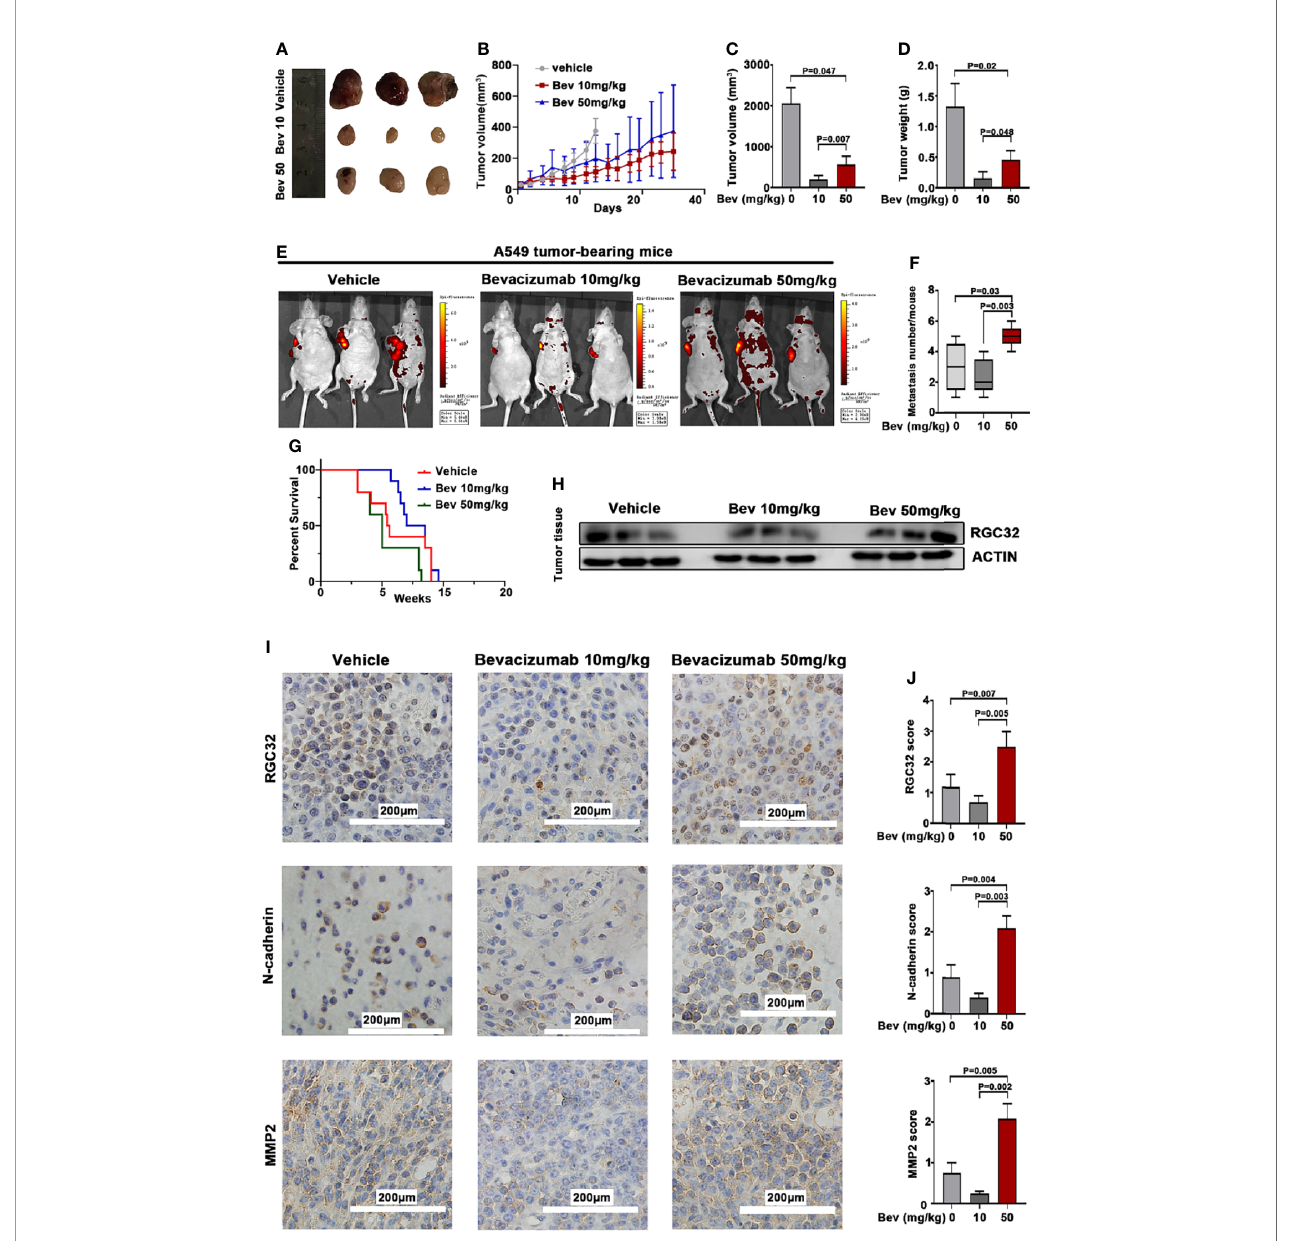
FIGURE 4 | Bevacizumab elevates RGC32, N-cadherin, and MMP2 expression, and promotes tumor metastasis while inhibiting primary tumor growth in subcutaneous transplanted tumors in mice. (A) Typical image of the primary tumors that formed in mice grafted with A549 cells on the right shoulder, which were treated with or without bevacizumab. Ruler unit: cm. (B) Primary tumor growth curves for each group. (C) Column diagram for the tumor volume with bevacizumab treatment. n = 3. (D) Column diagram for the tumor weight in each group. n = 3. (E) Representational images of mice with tumor cells transplanted and spontaneous metastasis monitored by the IVIS spectral imaging system. Colored bars represent radiation ef fi ciency. (F) Boxplot analysis of metastases focus number. n = 3. (G) Survival after 10 mg/kg bevacizumab, 50 mg/kg bevacizumab or vehicle treatment (n = 10, P = 0.0235) after documented tumor burden. Treatment started at week 0. Median survival 5.32 w for 50 mg/kg bevacizumab vs 7.69 w for 10 mg/kg bevacizumab treatment. (H) Western blot analysis of RGC32 expression in tumor tissues. (I) IHC to detect RGC32, N-cadherin and MMP2 in primary tumors. Representative images are shown. Magni fi cation ×400. (J) Column diagram of IHC scores in each group. Each column is the average of fi ve random fi elds per tumor. n = 3. Bev,